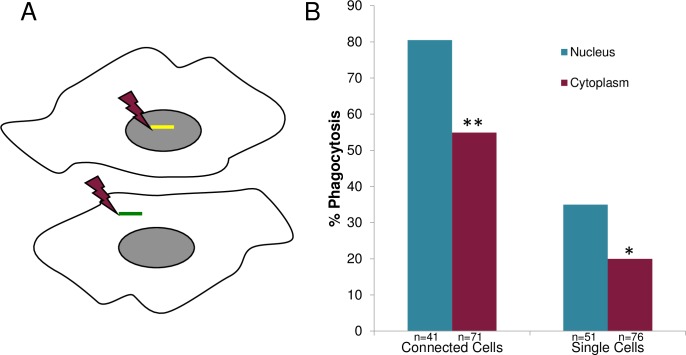
Nucleus targeted irradiation results in a higher phagocytic response than cytoplasm targeted irradiation.A. Schematic diagram depicting position of laser irradiation for nucleus targeted and cytoplasm targeted cells. B. A significant decreased in phagocytic response for cytoplasm-irradiated cells vs. nucleus-irradiated cells was observed for two categories: (1) cells with a membrane connection, and (2) isolated cells without a membrane connection. For connected cells, 80% (33/41) phagocytic response for nucleus-targeted astrocytes vs. 55% (39/71) for cytoplasm-targeted astrocytes was observed (**p>0.01). For isolated non-membrane-connected cells, we observed 35% (18/51) phagocytic response for nucleus-targeted cells versus a 20% (15/76) phagocytic response for cytoplasm-irradiated astrocytes (*p = 0.05).